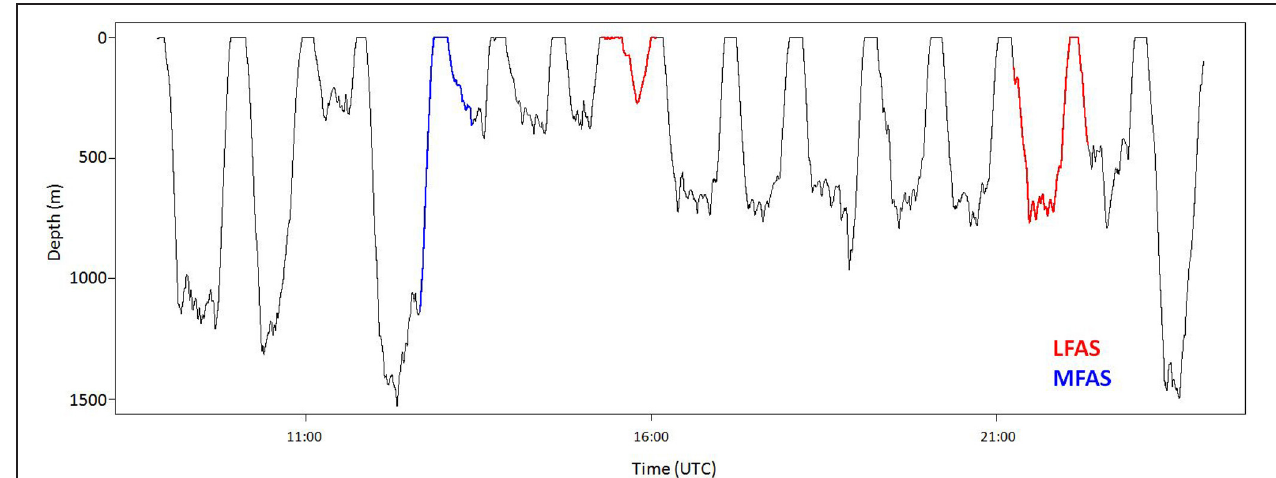
FIGURE 4 | Full dive record of sperm whale sw09_160a. Record show typical sperm whale dive behavior (Teloni et al., 2008) with deep dives followed by a surface period. During MFAS exposure (blue), the animal switched from normal deep dives to shallower but still deep diving.